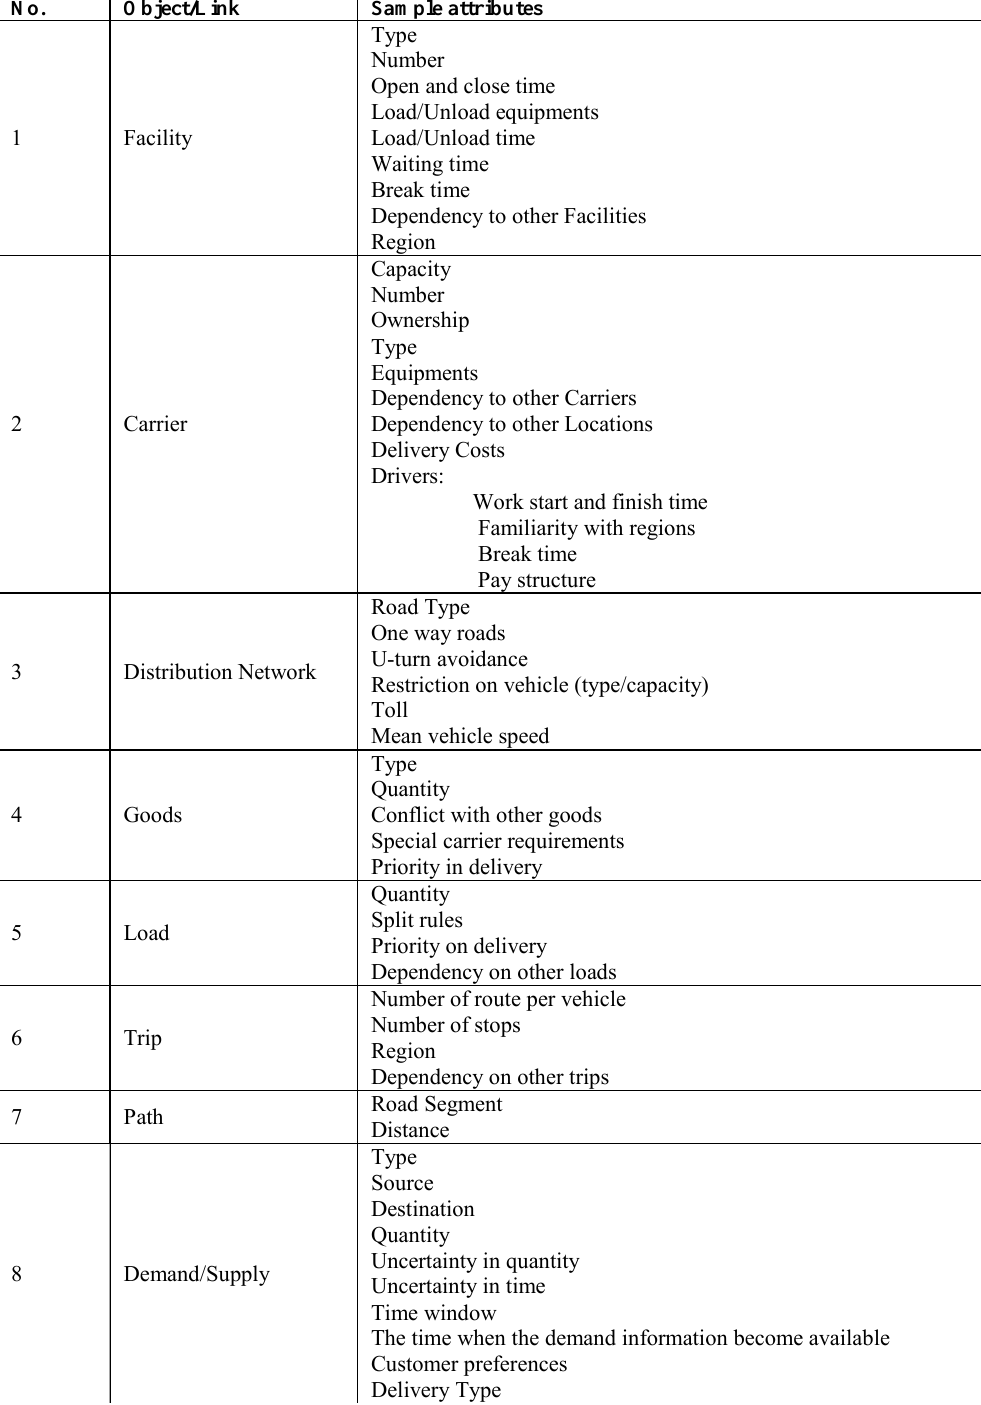
Sample attributes Object/Link